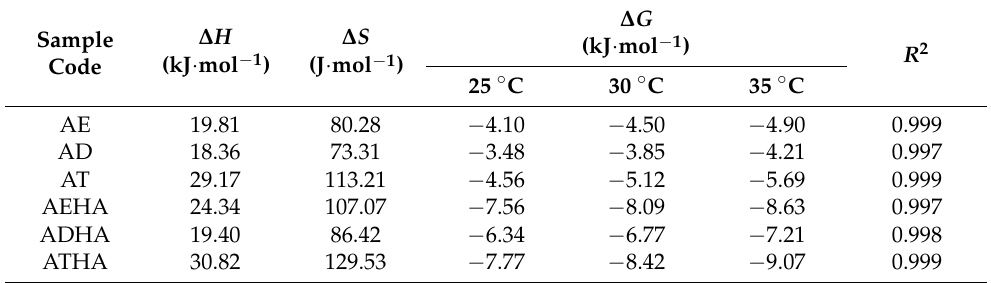
Table 12. Thermodynamic parameters.